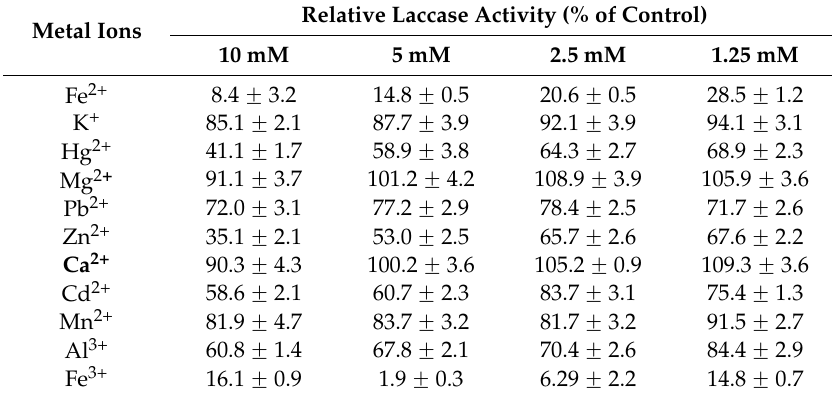
Table 3. Effects of various metal ions on laccase activity of Lepista nuda laccase. Metal